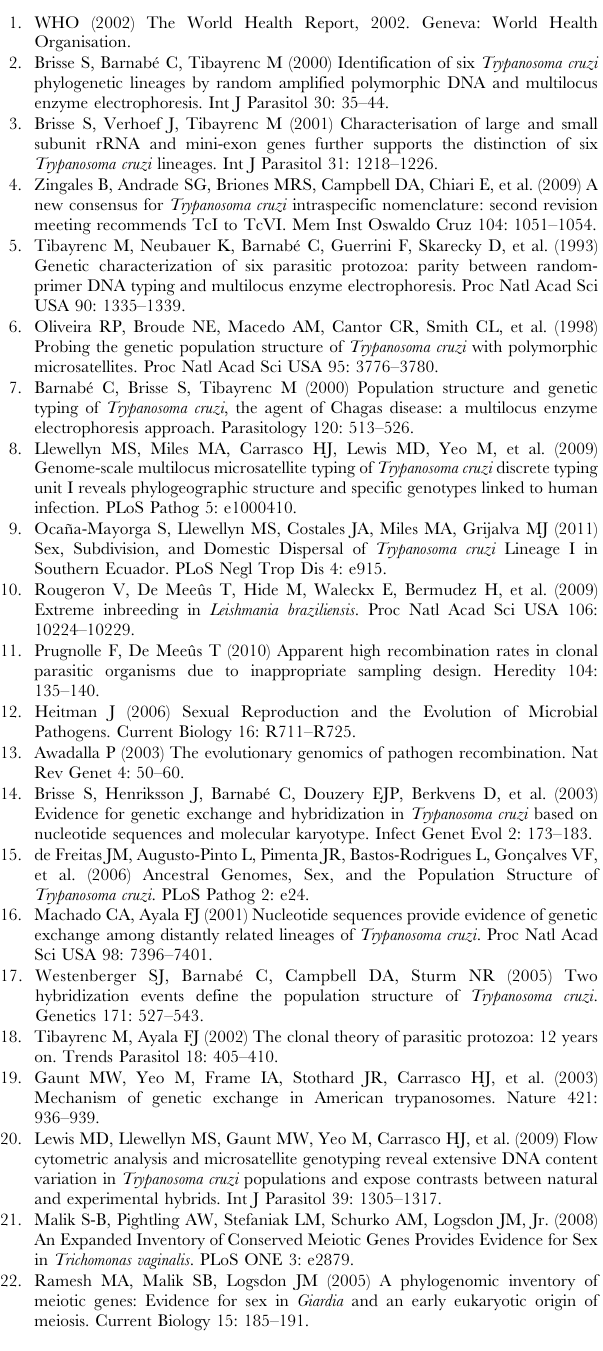
Table S2 Microsatellite locus information. Table S3 Sequence diversity summary statistics. Table S4 Multilocus microsatellite